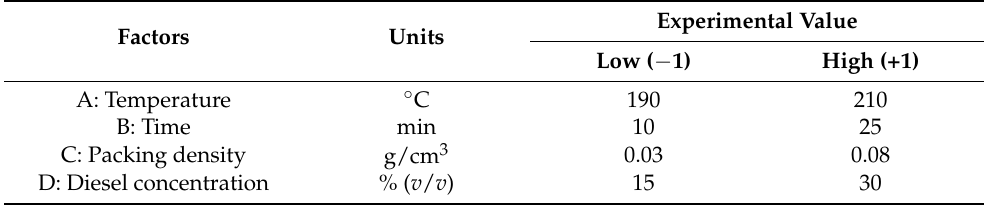
Table 7. PB design for experimental values and coded levels of factors analysed for the efficiency of diesel and seawater